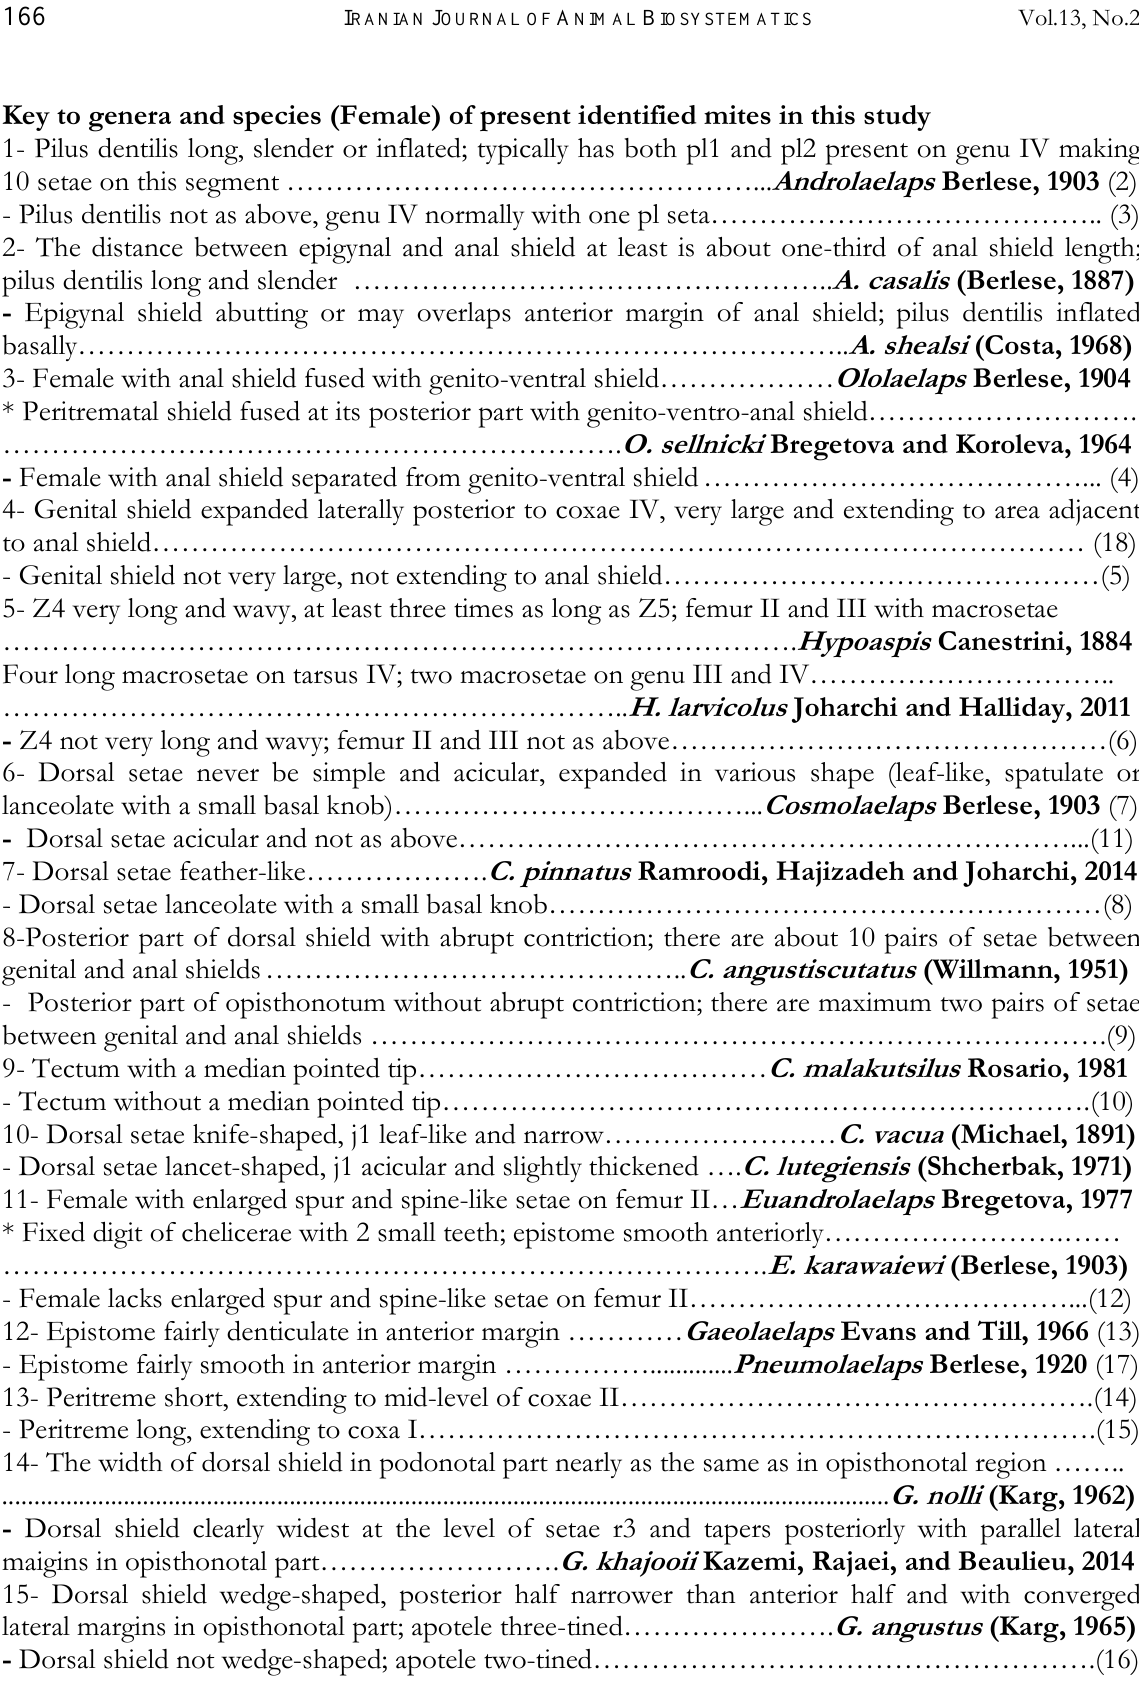
10- Dorsal setae knife-shaped, j1 leaf-like and narrow…………………… C. vacua (Michael, 1891) - Dorsal setae lancet-shaped, j1 acicular and slightly thickened …. C. lutegiensis (Shcherbak, 1971) 11- Female with enlarged spur and spine-like setae on femur II… Euandrolaelaps Bregetova, 1977 * Fixed digit of chelicerae with 2 small teeth; epistome smooth anteriorly…………………….…… - Female lacks enlarged spur and spine-like setae on femur II…………………………………...(12) 12- Epistome fairly denticulate in anterior margin ………… Gaeolaelaps Evans and Till, 1966 (13) - Epistome fairly smooth in anterior margin ……………............. Pneumolaelaps Berlese, 1920 (17) 13- Peritreme short, extending to mid-level of coxae II………………………………………….(14) - Peritreme long, extending to coxa I…………………………………………………………….(15) 14- The width of dorsal shield in podonotal part nearly as the same as in opisthonotal region …….. ........................................................................................................................................... G. nolli (Karg, 1962) - Dorsal shield clearly widest at the level of setae r3 and tapers posteriorly with parallel lateral maigins in opisthonotal part……………………. G. khajooii Kazemi, Rajaei, and Beaulieu, 2014 15- Dorsal shield wedge-shaped, posterior half narrower than anterior half and with converged lateral margins in opisthonotal part; apotele three-tined…………………. G. angustus (Karg, 1965) - Dorsal shield not wedge-shaped; apotele